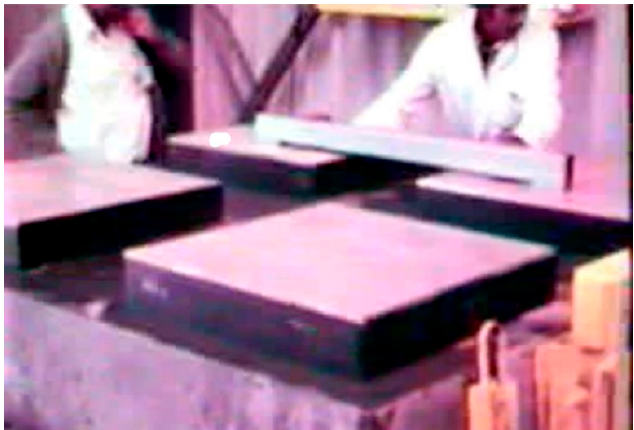
Figure 10. Flatness check of prefabricated bearing assembly before shipment to site [6].